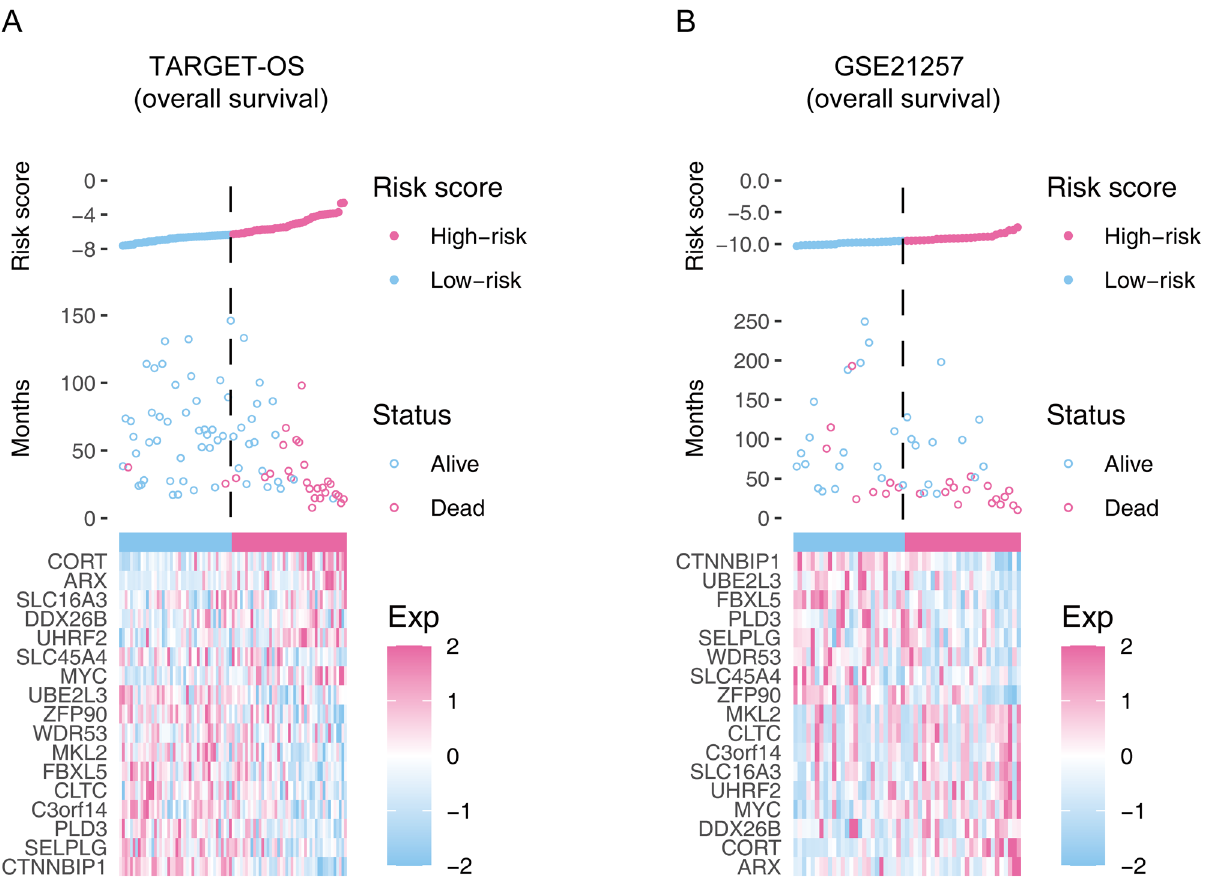
Figure 3. The overall distributions of the risk score (upper), survival status (middle), and gene expression profiles (bottom) of the seventeen-gene signature in the training ( A ) and validation ( B )